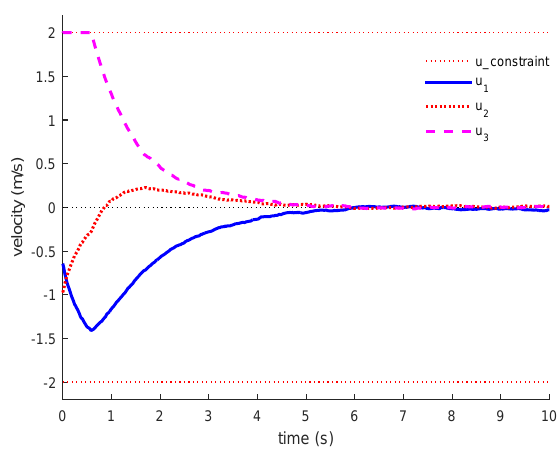
Figure 7. The velocity inputs of three mecanum wheels.